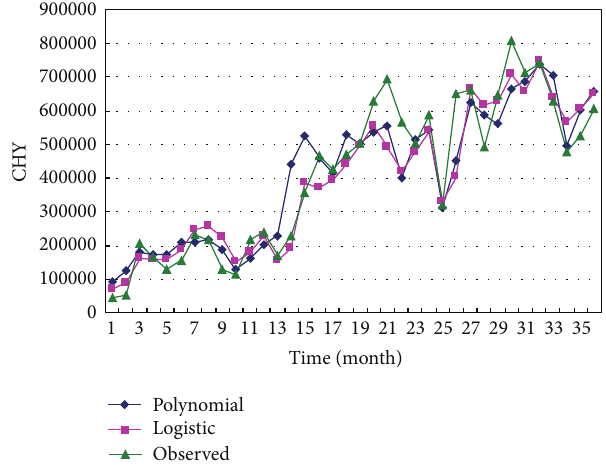
Figure 12: Comparison of the results of the two forecasting models: income.